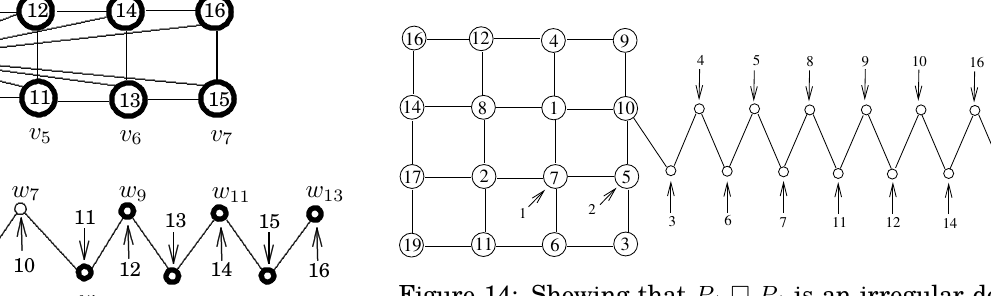
Figure 14: Showing that P nation